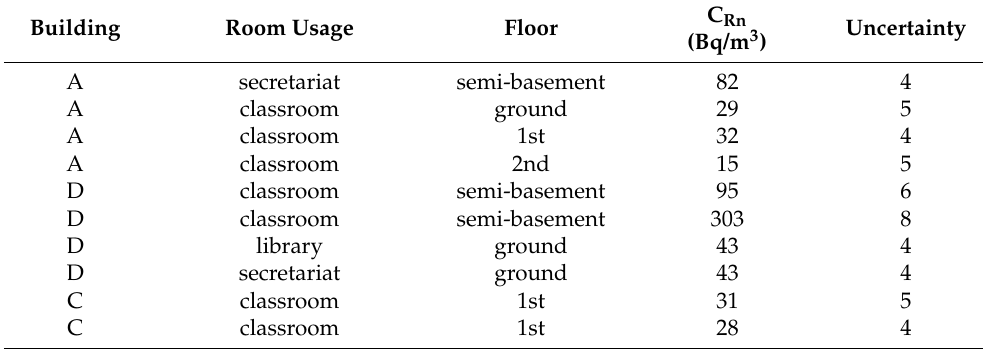
Table 3. Location of rooms and the variation of indoor radon concentration in school